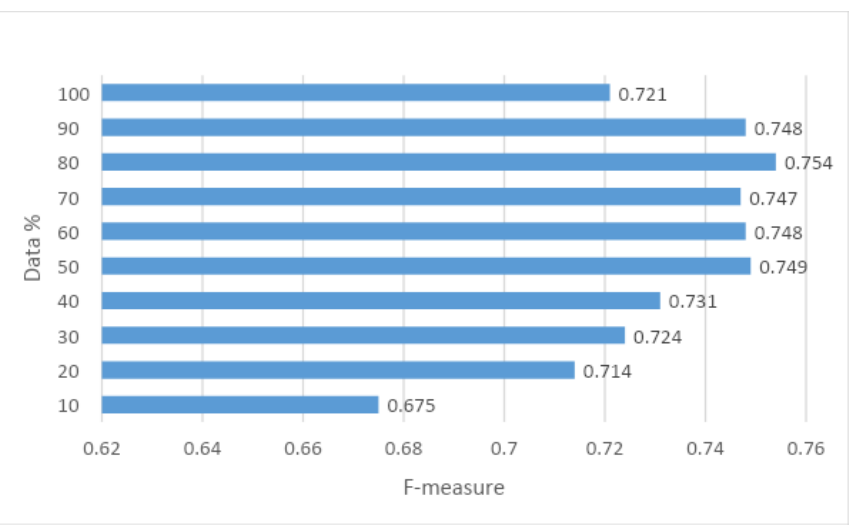
Figure 5. F ‐ measure for Naïve Bayesian with a random projection. Figure 5. F-measure for Naïve Bayesian with a random projection.